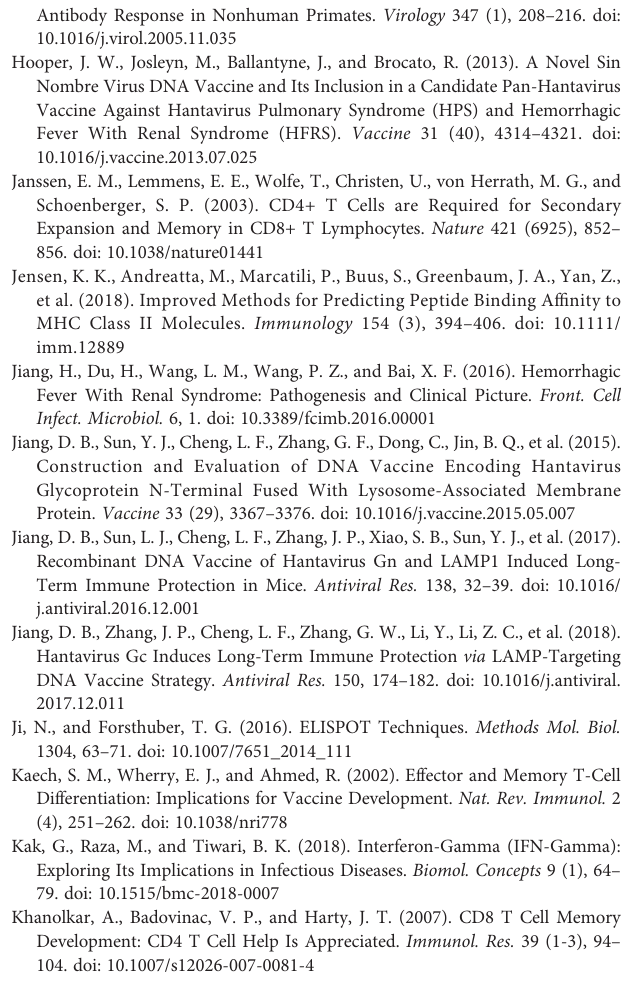
118. Groups (A – D) are the results obtained from C57, BALB/c, C3H, and Kunming mice. Experimentally derived epitopes were screened and compared to predicted epitopes. Supplementary Figure 2 | Conservation analysis by multiple sequence alignment. The overall height of the stack indicates sequence conservation at that position,whilethe heightofsymbolswithinthe stackindicates therelativefrequency of each a.a. or nucleic acid at that position, with a.a.s colored according to their chemical properties as follows: polar (G, S, T, Y, C, Q, and N), green; basic (K, R, and H), blue; acidic (D and E), red; and hydrophobic (A, V, L, I, P, W, F, and M), black.Predictedepitopesfromhuman,mouse,andbothareunderlinedinblue,red, and orange, respectively. Supplementary Figure 3 | Heatmap illustrating the interaction between MHC-II molecules and predicted epitopes. Columns and rows show MHC-II subtypes and epitopes, respectively. Darker colors represent a stronger interaction (lower